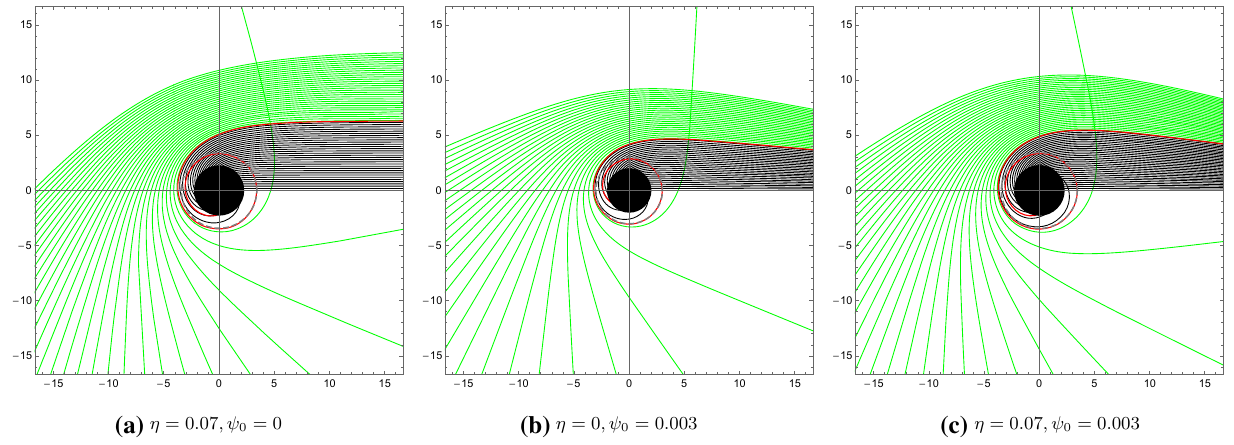
(b) η = 0 ,ψ 0 = 0 . 003 (c) η = 0 . 07 ,ψ 0 = 0 . 003 Fig. 2 The trajectories of light ray for different values of η and ψ 0 in the polar coordinates ( r ,φ)